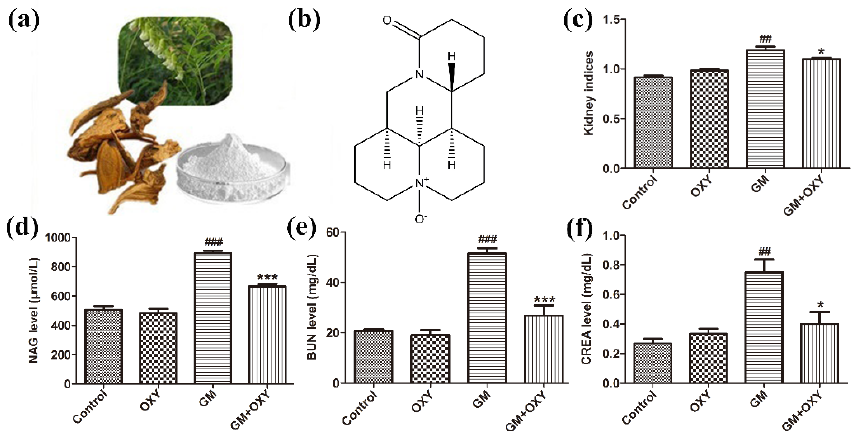
Figure 1. Oxymatrine alleviated gentamicin-induced nephrotoxicity in rats. ( a ) Sophora flavescens ait (the Chinese herb Kushen). ( b ) Chemical structure of OXY; ( c ) kidney indices (kidney organ coefficient). ( d ) Urinary NAG levels. ( e ) Serum BUN and ( f ) CRE levels. Data are presented as means ± SD ( n = 10). ## p < 0.01 and ### p < 0.001 compared to the control group; * p < 0.05 and *** p < 0.001 compared to the GM treatment